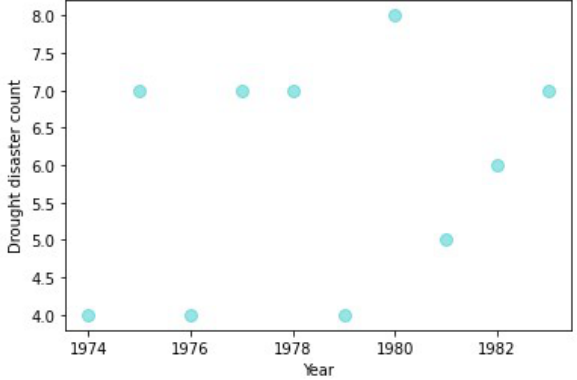
Figure 1 . Counts of drought in Yucheng city from 1974 to 1983.